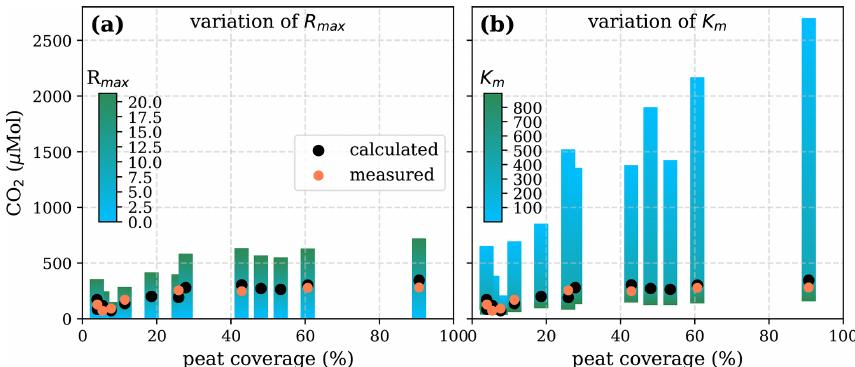
Figure A4. Sensitivity of calculated CO 2 to (a) the maximum decomposition rate ( R max ) and (b) the Michaelis constant for O 2 concentration ( K m ) according to the equation in Table 1 for the linear pH approach and the parameter ranges given in Table